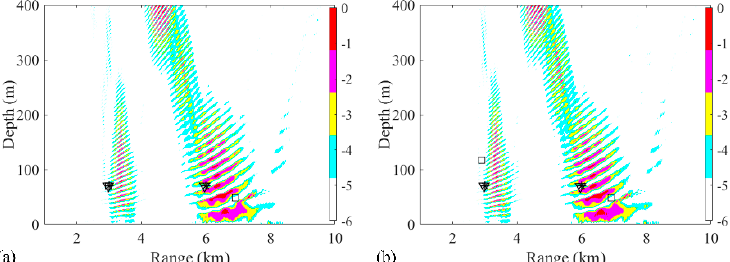
Figure 6. ( a , b ) Ambiguity surfaces generated by different realizations with the elements of the VLA 2 m apart (from 1735 to 1859 m). True source positions and the positions estimated by the RAMP and RAMPMF methods are represented as black asterisks, squares, and inverted triangles, respectively.